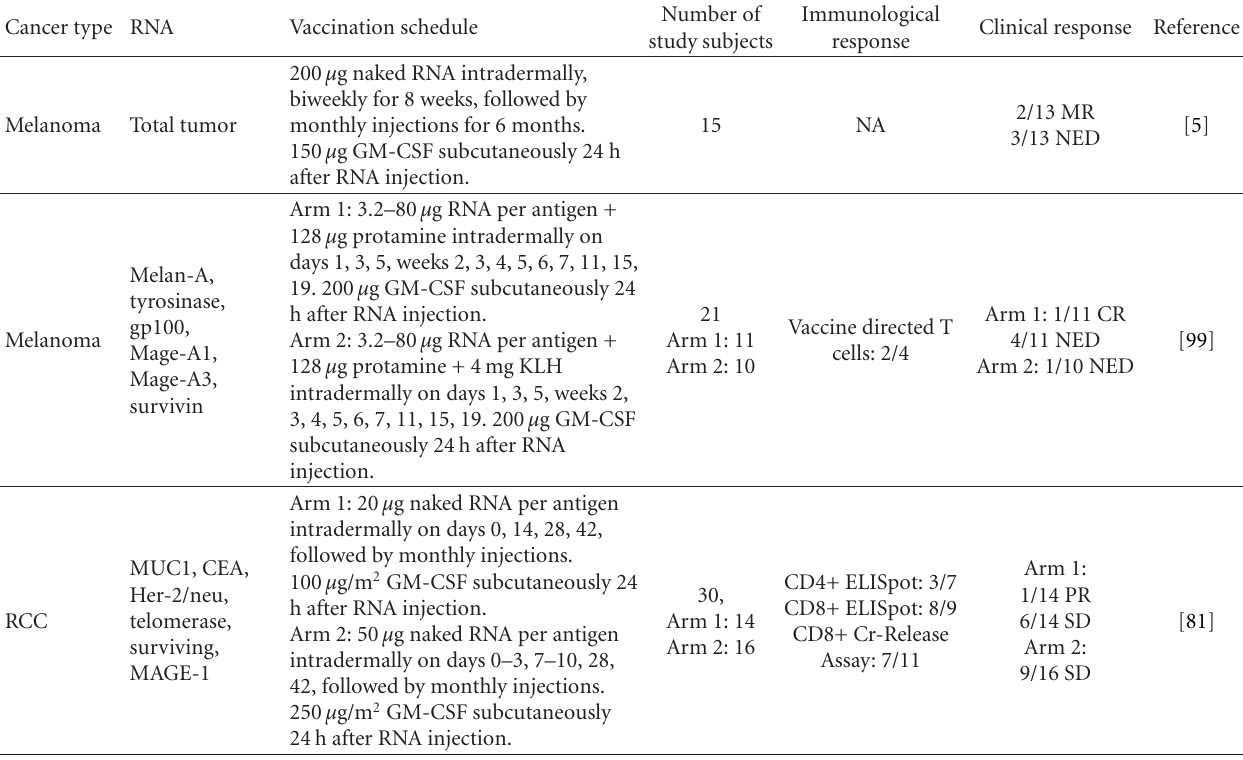
Table 2: Recent clinical trials using